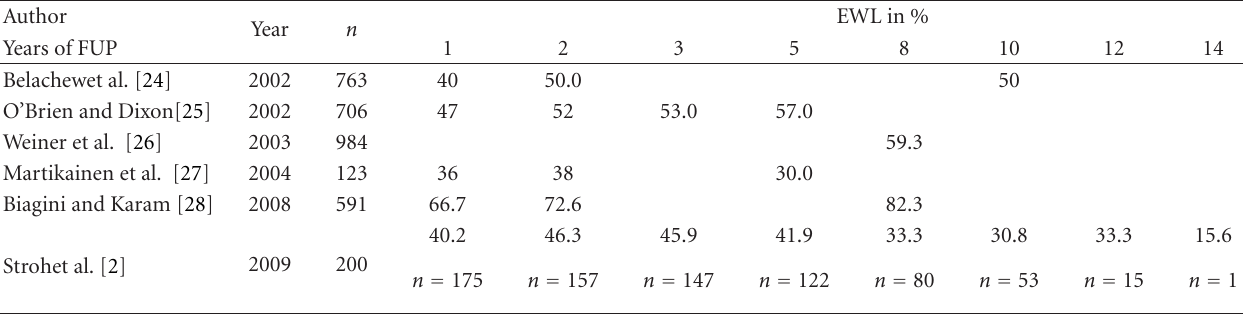
Table 5: Excess body weight loss in comparison with